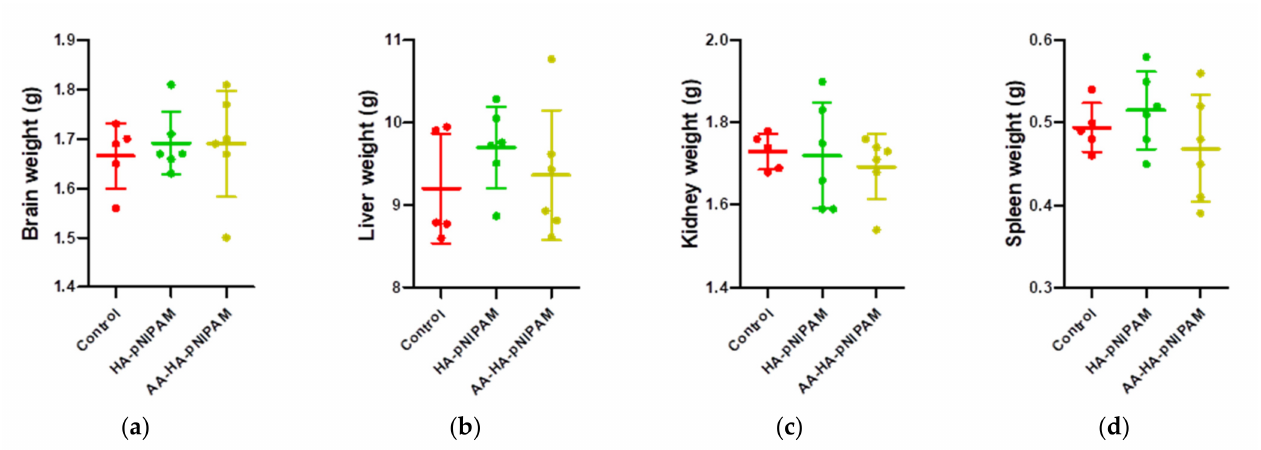
Figure 9. Organ weights of rats treated with control, HA-pNIPAM and AA-HA-pNIPAM. The organs weighed at necropsy included ( a ) brains; ( b ) livers; ( c ) kidneys and ( d )